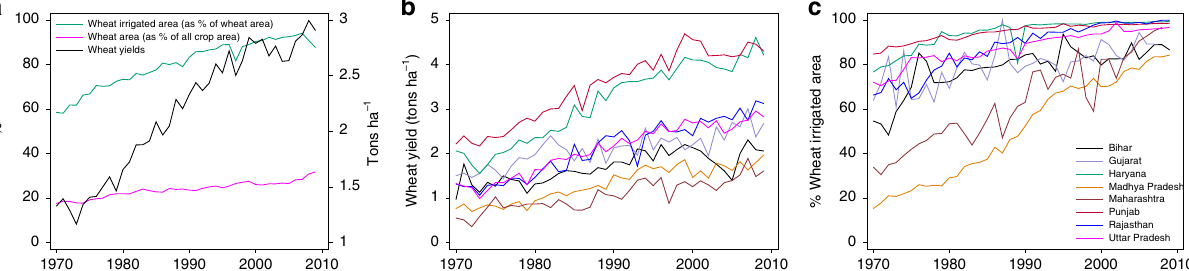
Fig. 1 National aggregate trends in irrigation coverage, cropped area and yields, trends in yield and irrigation coverage across major wheat-producing states. Percent of wheat irrigated area is the percent of wheat cropped area that is irrigated. Percent of wheat area is the percent of total cropped area that is planted with wheat. Wheat yield is the production of wheat (in tons) per hectare. Source data are provided as a Source Data fi